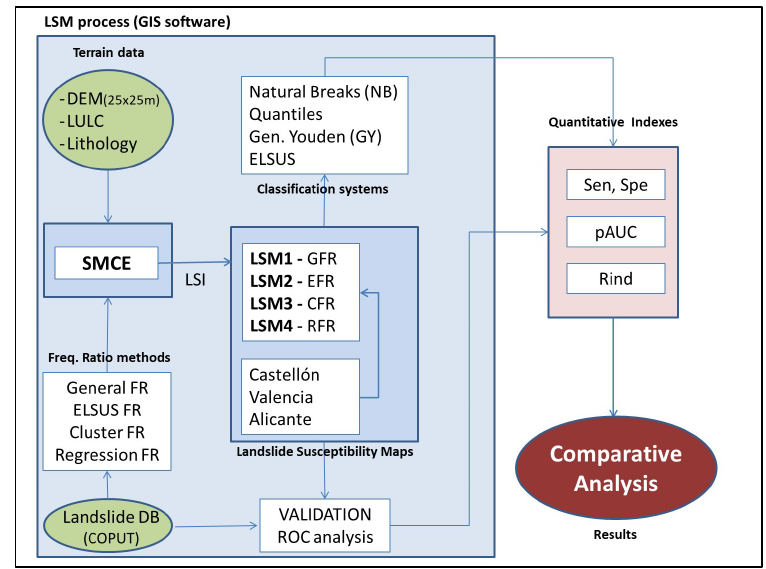
Figure 3. General methodology flowchart with the comparative analysis.